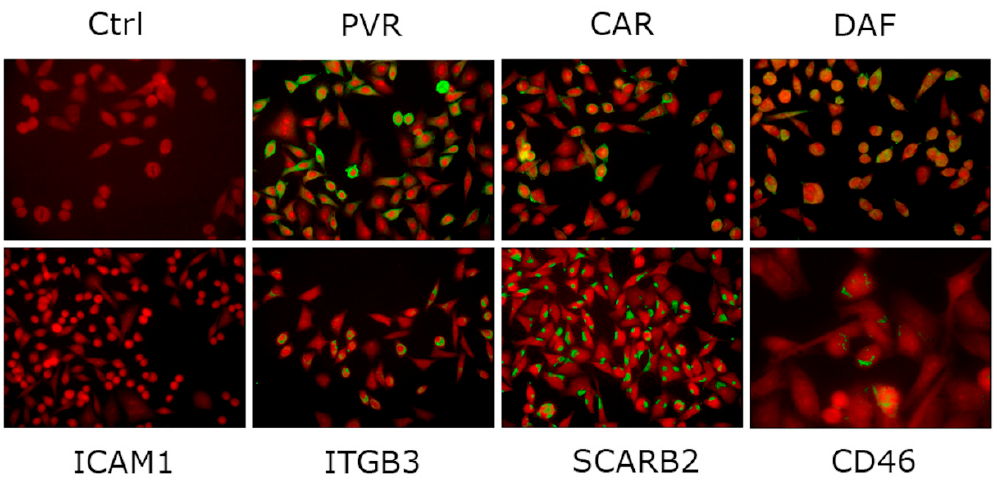
Figure 1. Immunofluorescent staining of AV3 cell monolayers with antibodies to representative enterovirus receptor molecules: poliovirus receptor (PVR), coxsackie-adenovirus receptor (CAR), complement regulator decay-accelerating factor (DAF), intercellular adhesion molecule 1 (ICAM1), integrin alpha-V / beta-3 (ITGB3); scavenger receptor class B member 2 (SCARB2); human herpesvirus-6 receptor CD46. Ctrl, cell monolayer incubated with secondary antibody only. Blue Evans counterstaining; original magnification, 250×.